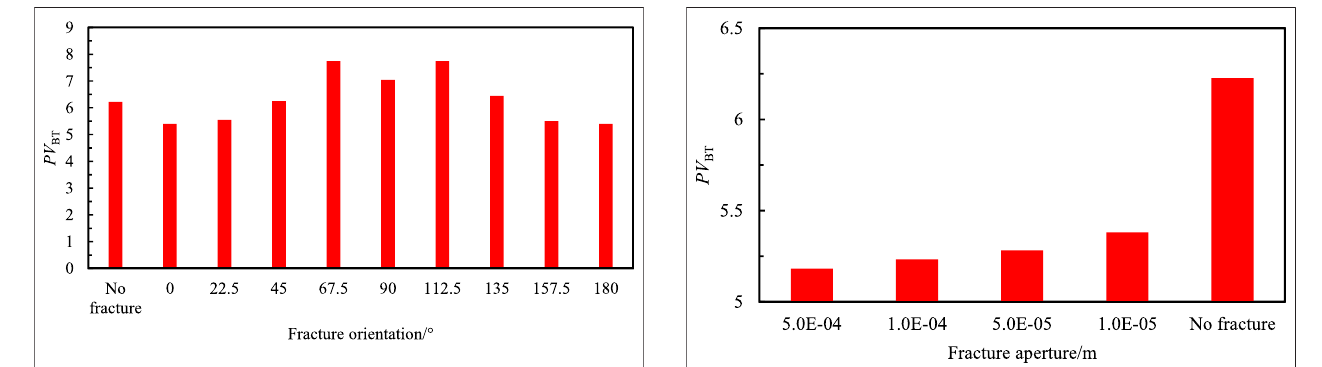
FIGURE 6 | The breakthrough volume of injected acid at different fracture orientations.